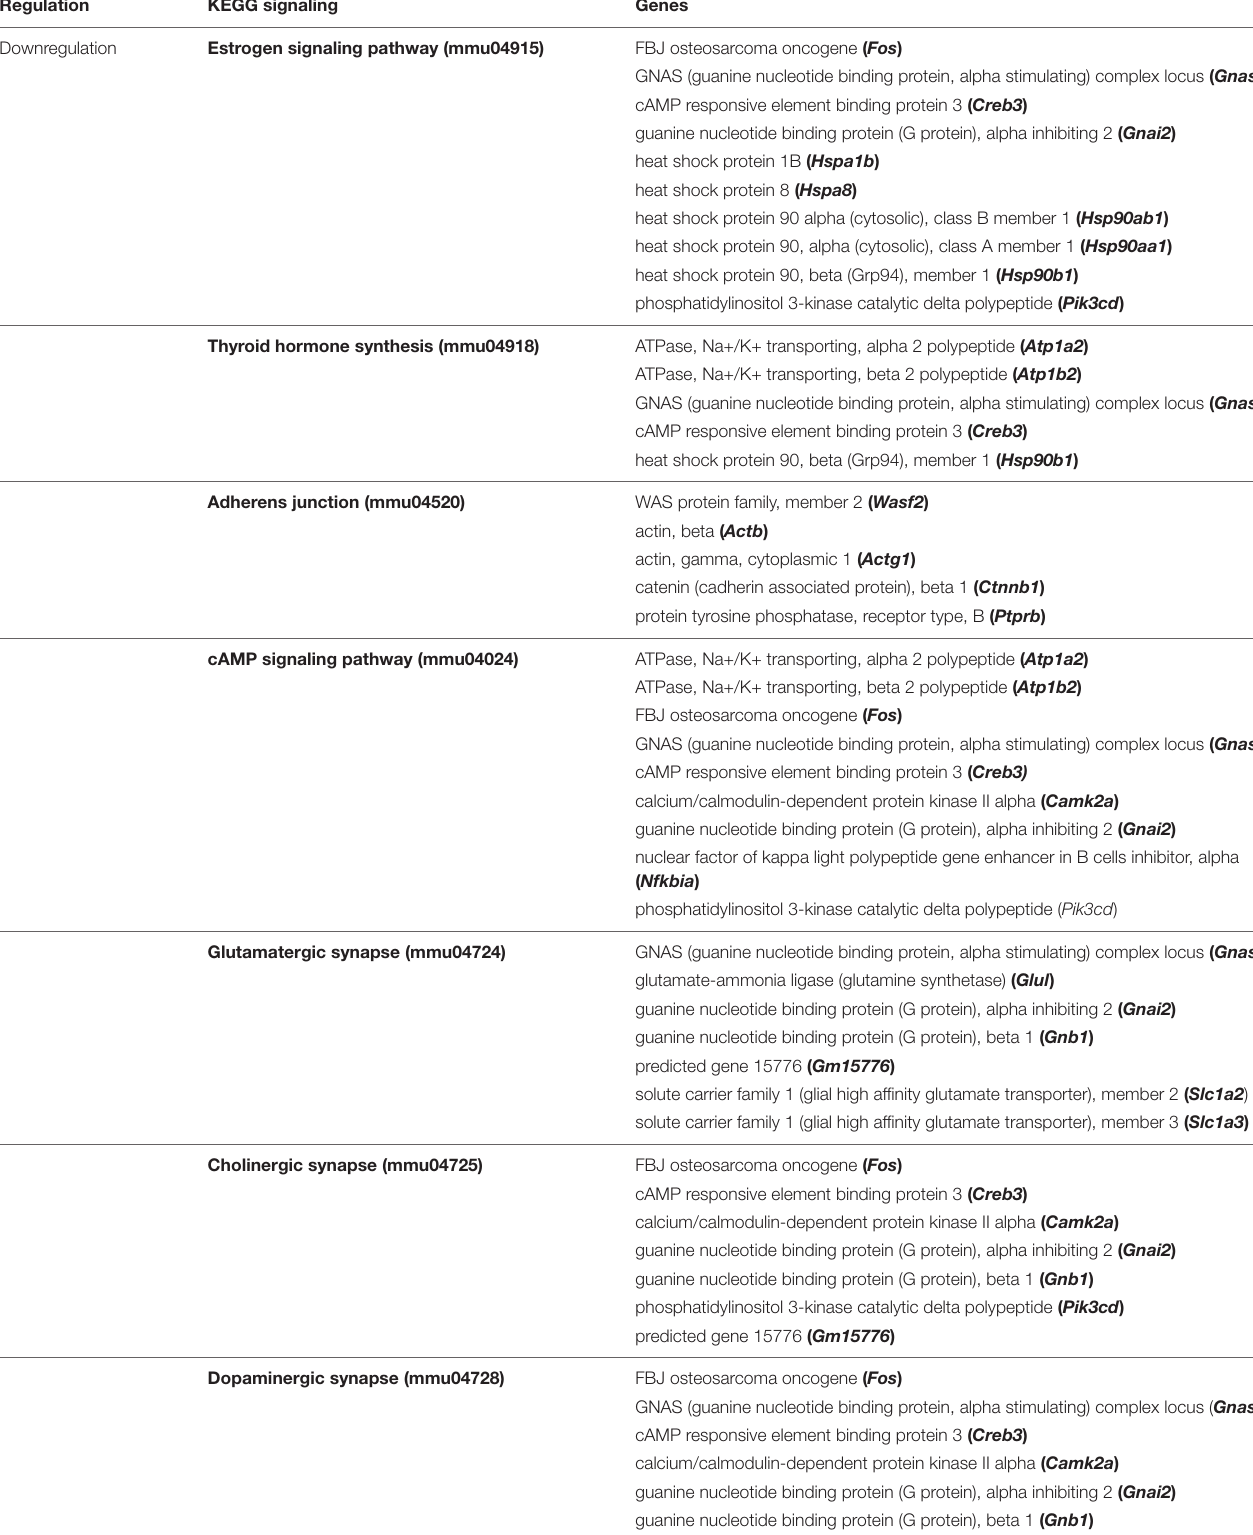
TABLE 1 | Top significantly enriched KEGG signaling pathways in NSCs of LPS-induced depression mice (LPS) compared to untreated mice